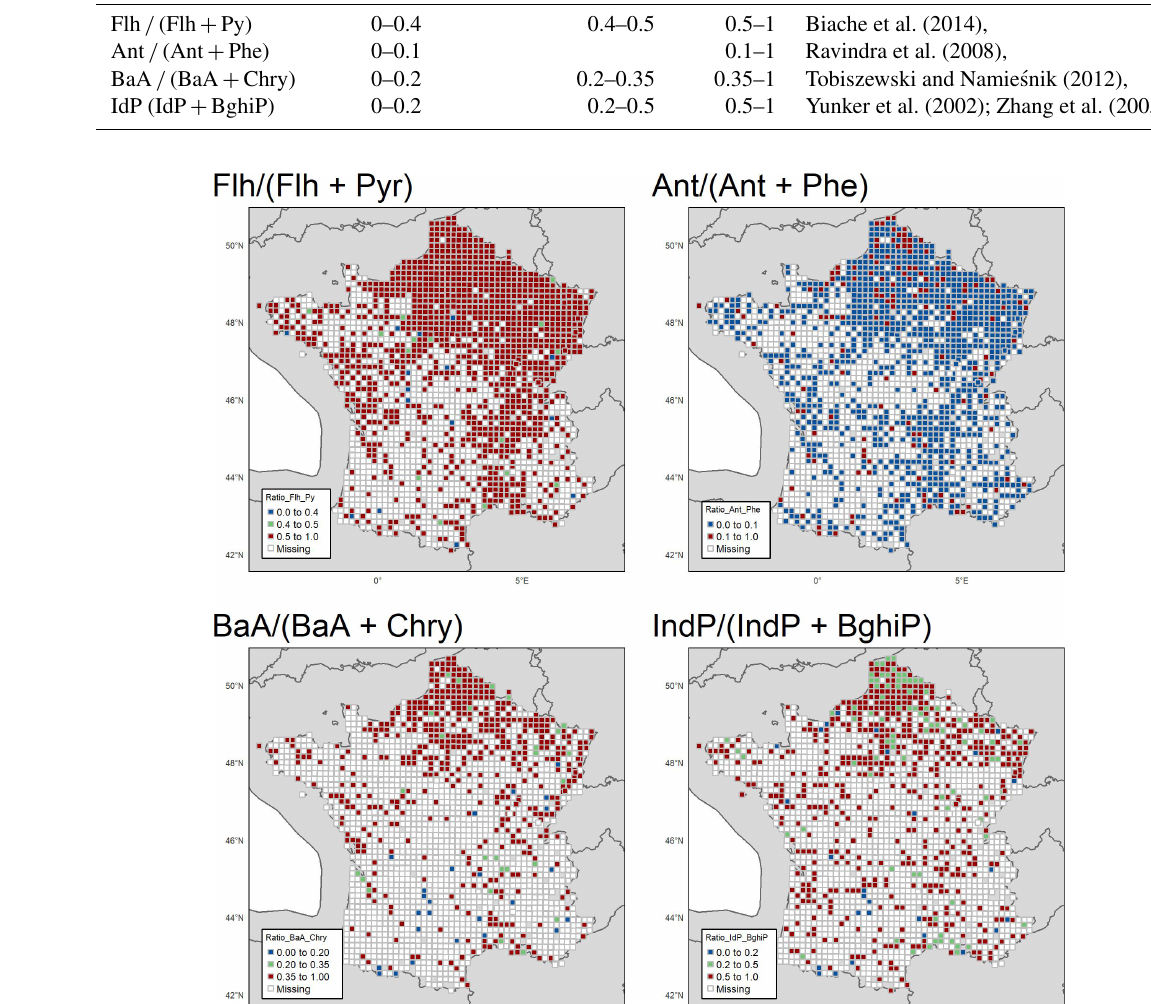
Figure 2. Spatialised molecular diagnostic ratios in French soils. Missing values correspond to sites at which none of the PAHs used in the ratios were